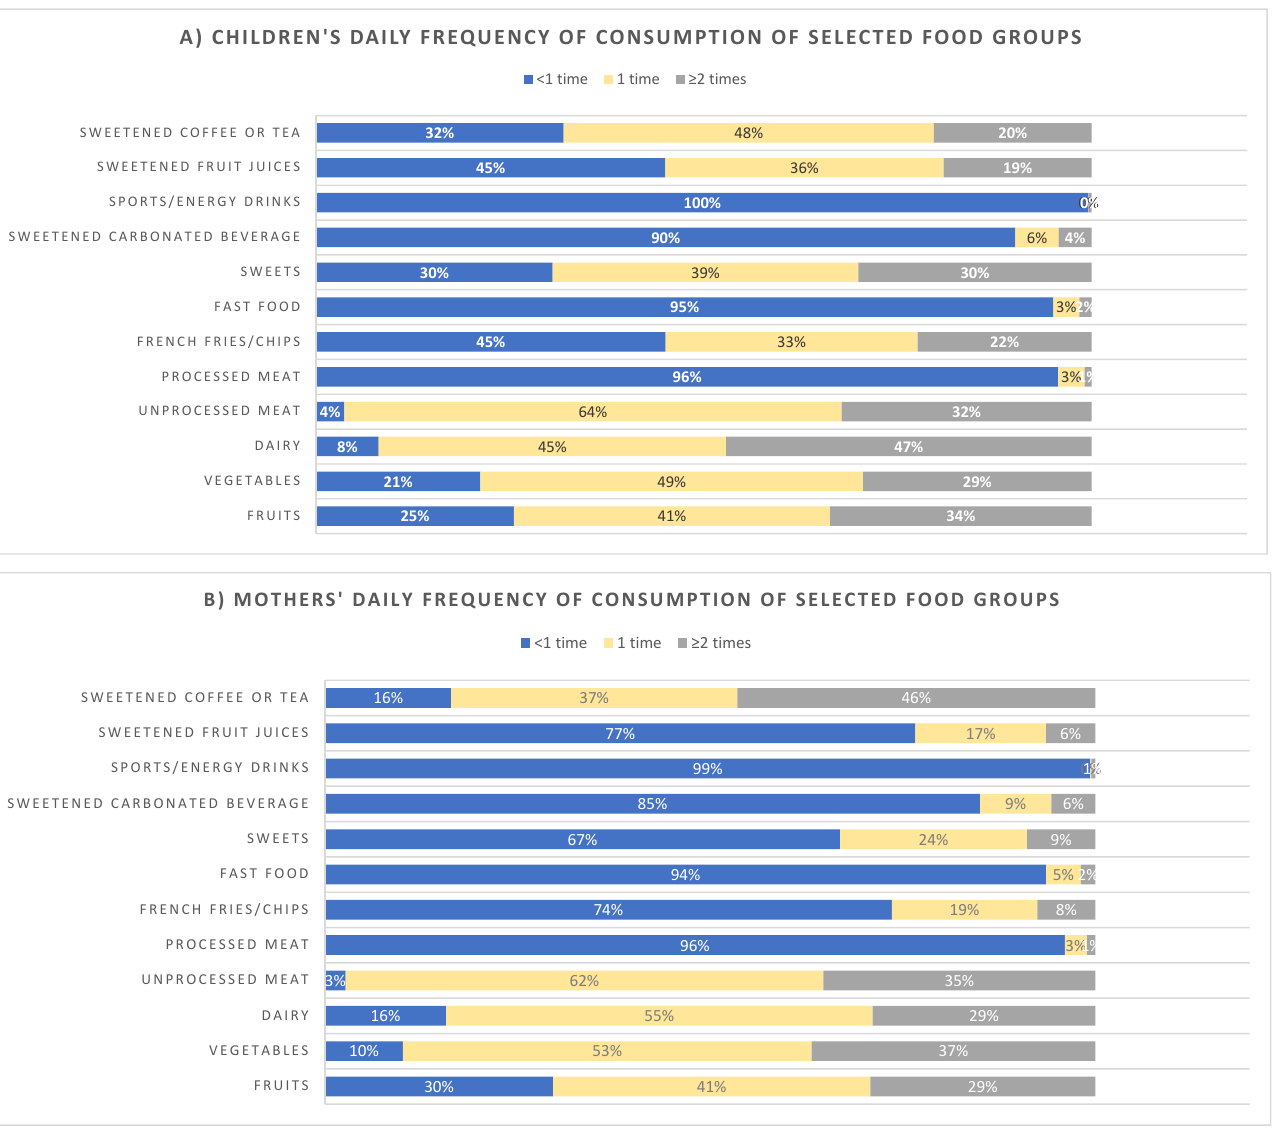
Figure 1. Daily frequency of consumption of selected food groups of ( A ) children (top panel) and ( B ) mothers (bottom panel). Table 2 summarizes the PA and media exposure of children and mothers. Around 41% of children walked to a destination most days of the week. On average, children played outdoors for 30 min or more 5 days a week. A small percentage of preschoolers (13%) participated in structured PA, and the mean daily PA duration of children was 22 min for all activities combined. Around one third of children were exposed to media outlets while eating on a daily basis and had a TV or a computer in their bedroom (Table 2). As for mothers, few walked on a daily basis for errands and about one quarter participated in structured PA. Around 10% of mothers had work errands that required vigorous or moderate PA. When mothers’ work involved vigorous or moderate PA, its duration ranged between 17 and 23 h per week. Daily media exposure during meals was less frequent among mothers with only 5% of women consuming their meals while watching TV (Table